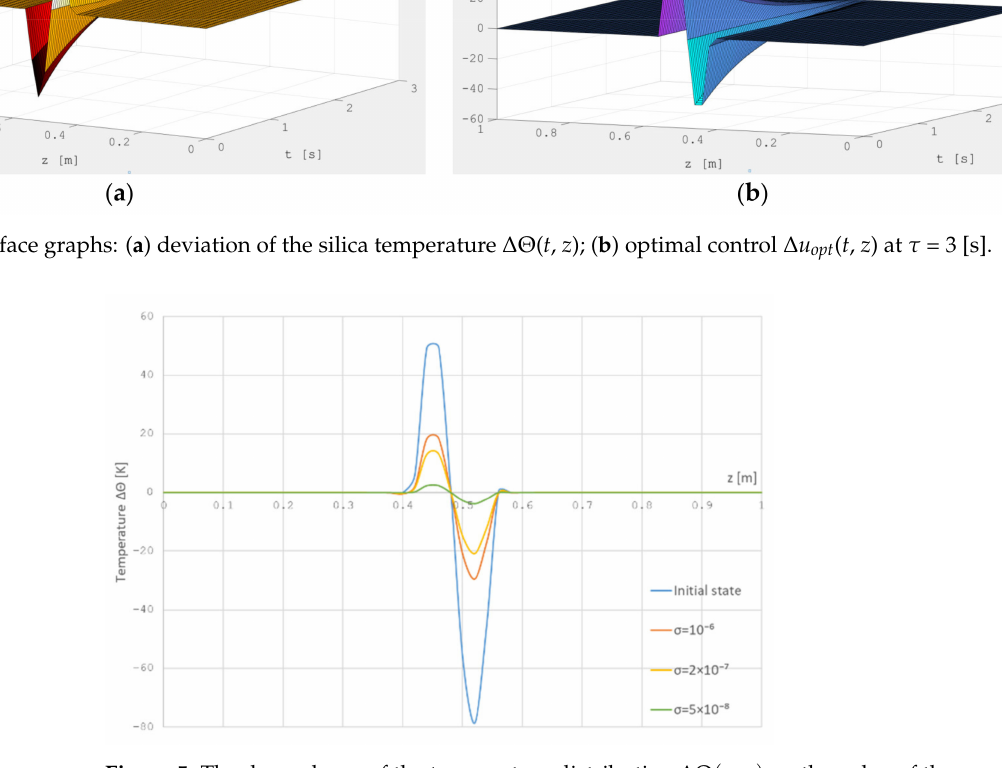
Figure 5. The dependence of the temperature distribution ∆Θ ( τ , z ) on the value of the parameter σ .